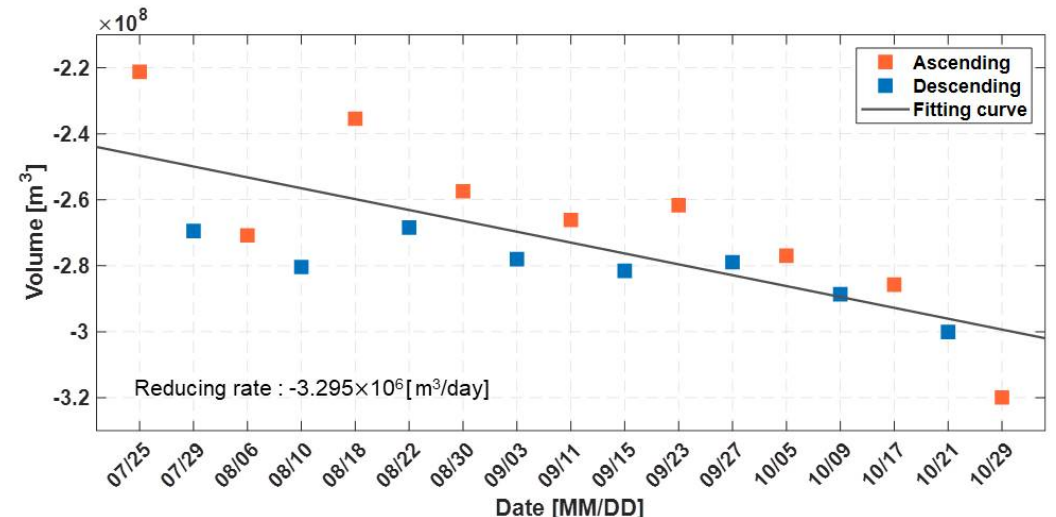
Figure 8 . Graph showing gradually decreasing water volume in the Xe-Namnoy reservoir. Figure 8. Graph showing gradually decreasing water volume in the Xe-Namnoy